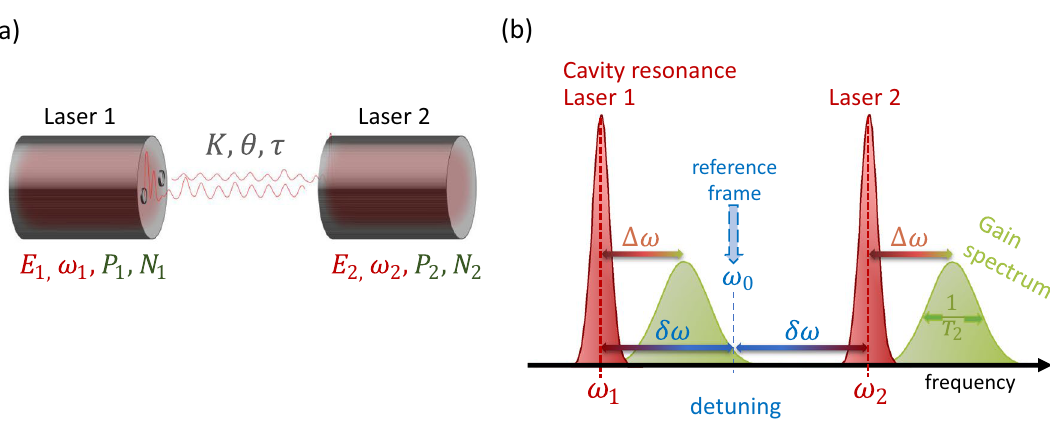
Figure 1. ( a ) Sketch of the coupling scheme and relevant dynamical variables and parameters. ( b ) Frequency scheme of the uncoupled lasers. The cold cavity frequencies ω 1,2 of the lasers are detuned by 2 δω . For both lasers there is a shift �ω between cavity resonance and gain maximum. The gain width is proportional to 1 T (figure not to